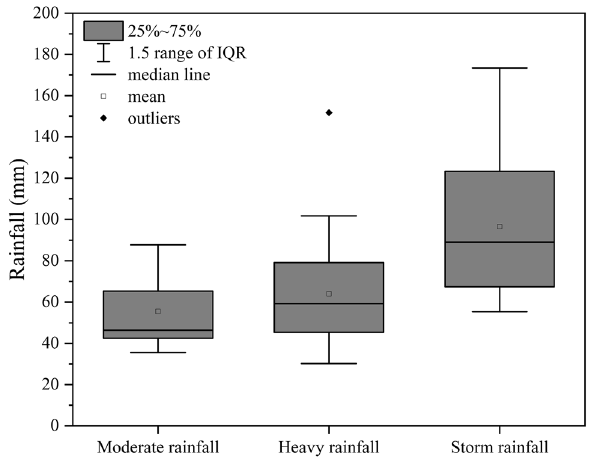
Figure 2. Box plot for moderate rainfall, heavy rainfall and storm rainfall respectively.